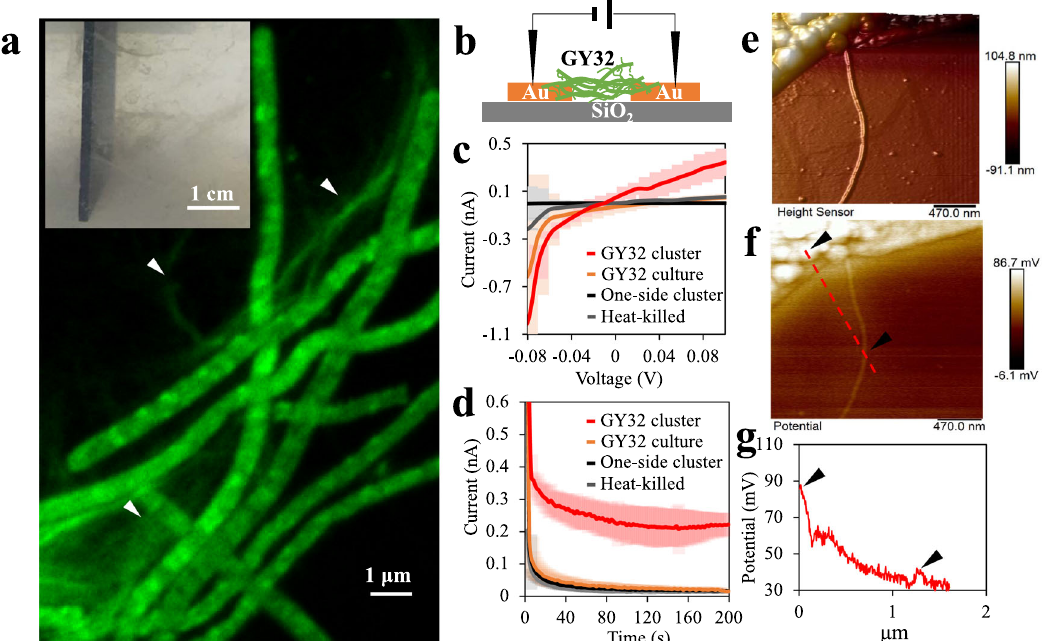
Fig. 3 Conductive cellular networks of strain GY32. a GY32 networks comprising fi lamentous cells and nanowire-like appendages stained by Nano- Orange. Inset shows the in situ networks around anode in an MFC, triangles indicate appendages. b Schematic of conductance measurement of the hydrated GY32 cell cluster. c Current – voltage pro fi les of live GY32 cell clusters and control samples ( n = 18 independent bacterial cultures). d Current – time pro fi les of live GY32 cell clusters and control samples (the voltage is 0.1 V, n = 18 independent bacterial cultures). e 3D-topography image of dehydrated GY32 and an appendage. f Surface potential image according to ( e ). g Representative surface potential pro fi le along the red line in ( f ), triangles indicate the locations of cell body and appendage. Data in ( c ) and ( d ) are plotted as mean and standard deviation. Source data are provided as a Source Data fi